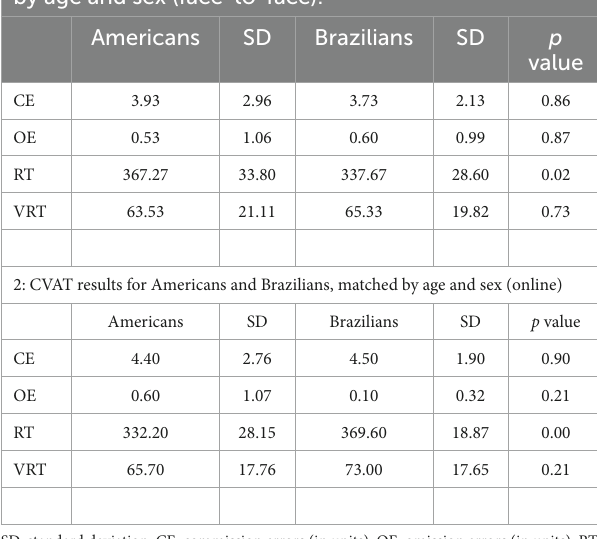
2: CVAT results for Americans and Brazilians, matched by age and sex (online)